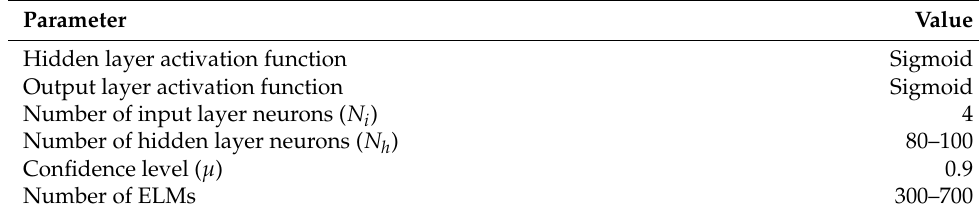
Table 2. Optimal values of the BELM ’s hyperparameters.